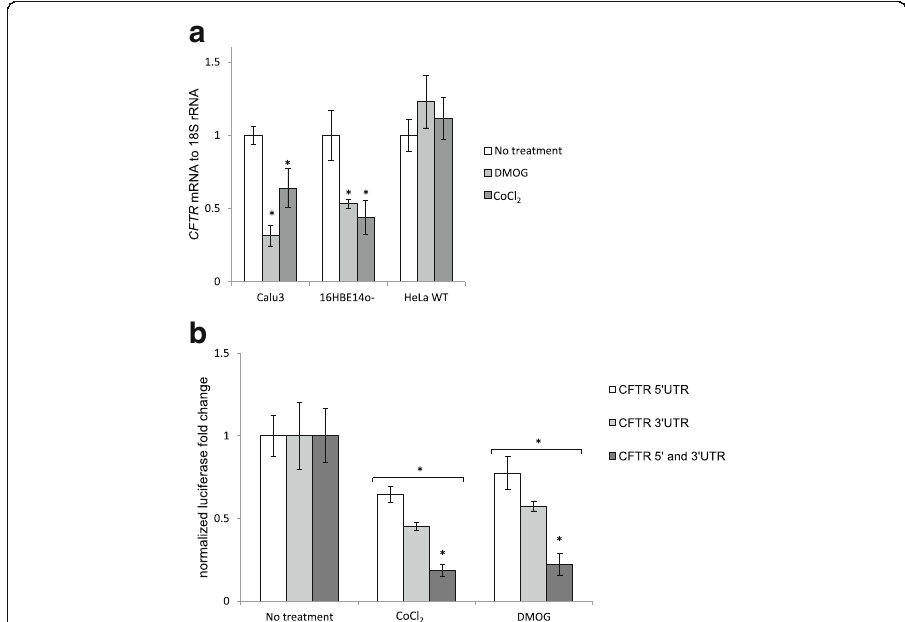
Fig. 2 Downregulation of CFTR expression during hypoxia is HIF-1 dependent and relies on both the 5 ′ and 3 ′ UTRs of CFTR mRNA. a Calu3, 16HBE14o- and HeLa WT CFTR cells were treated with hypoxia mimetics (500 μ M DMOG for 12 h (light grey) and 200 μ M CoCl 2 for 12 h (dark grey)) and the mRNA levels were monitored in qRT-PCR experiments. CFTR mRNA levels from 2 independent experiments ( n = 8) are plotted relative to 18S rRNA levels and expressed as a fold change over the untreated control. b Calu3 cells were transfected with 5 ′ UTR CFTR luciferase reporter (white), 3 ′ UTR CFTR luciferase reporter (light grey) and co- transfected with both 5 ′ UTR and 3 ′ UTR CFTR luciferase reporters (dark grey) and treated with hypoxia mimetics (500 μ M DMOG or 200 μ M CoCl 2 for 12 h) and the luciferase activity was monitored. These reporters were normalized to internal controls ( Renilla ) firefly luciferase activities from 2 independent experiments ( n = 6) and plotted and expressed as a fold-change over non-treated control. Error bars represent standard deviations. Significant changes ( P < 0.05) are marked with an